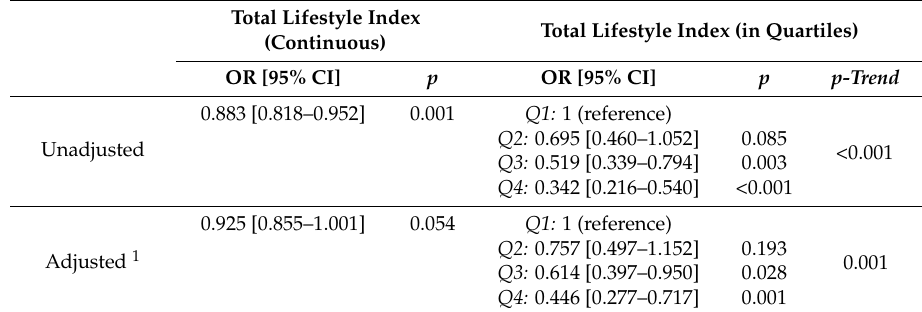
Table 4. Results from logistic regression analysis that evaluated the association between TLI and MCI (dependent variable) in non-demented participants.